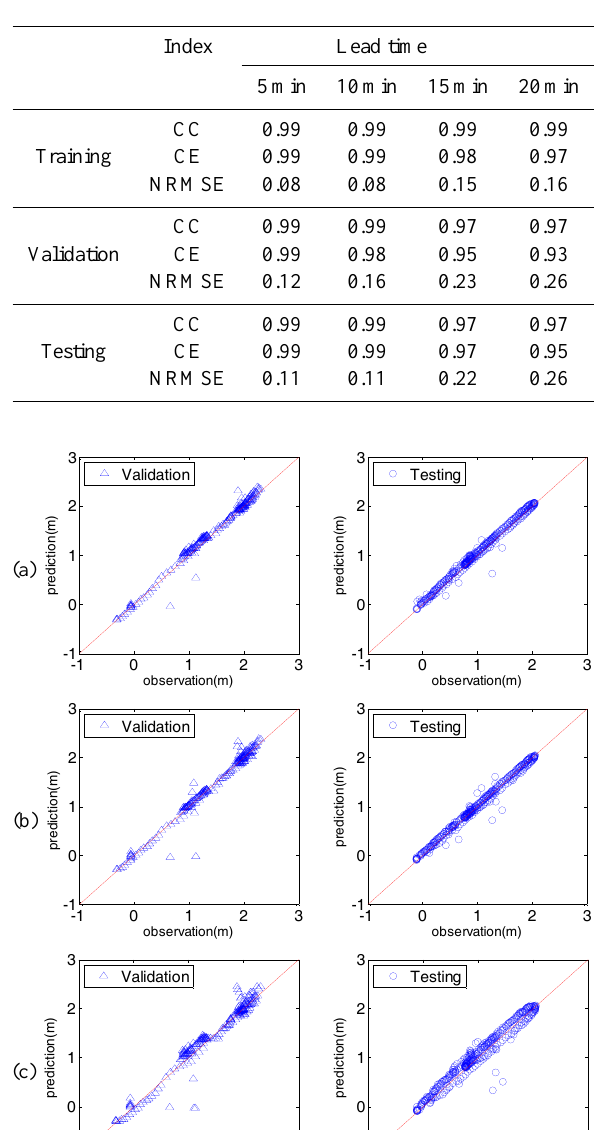
Table 2. Results obtained from the RNN for water level prediction at Station YC10.